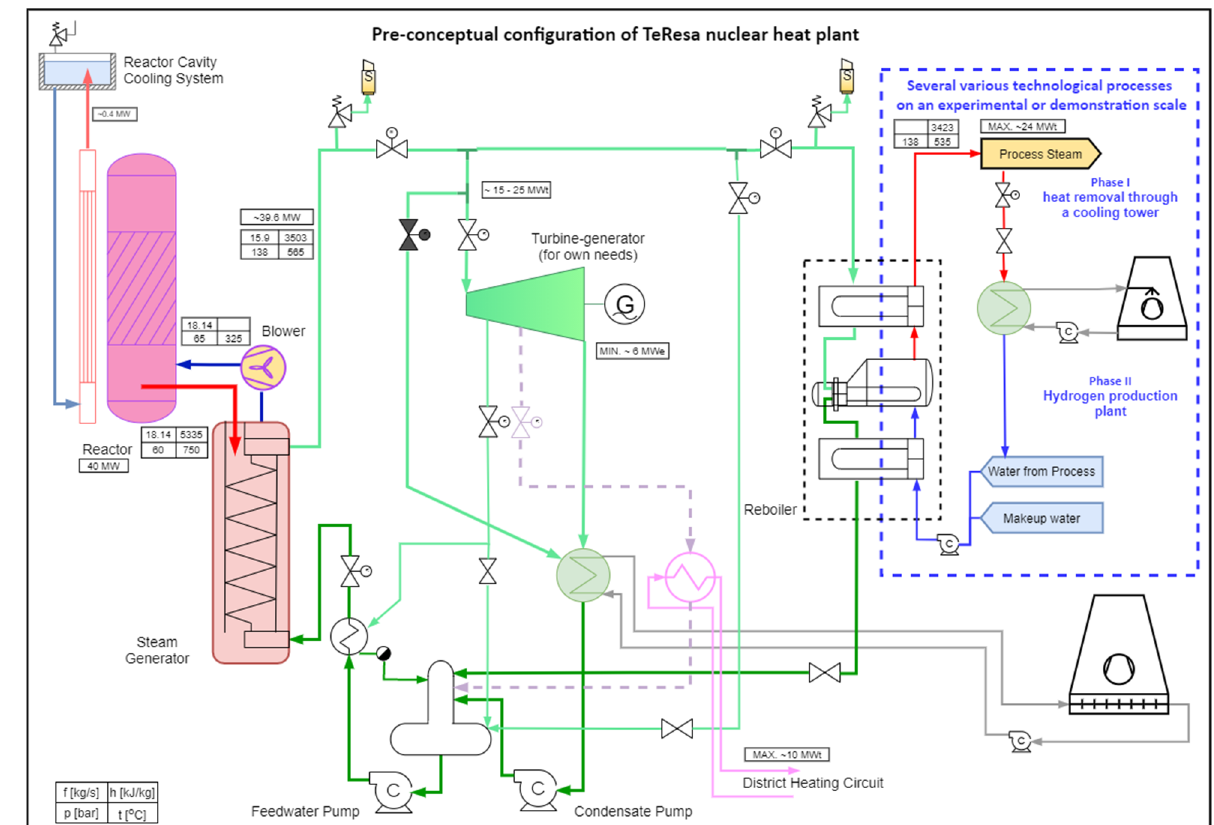
Figure 1. The TeResa facility pre-conceptual design [22].